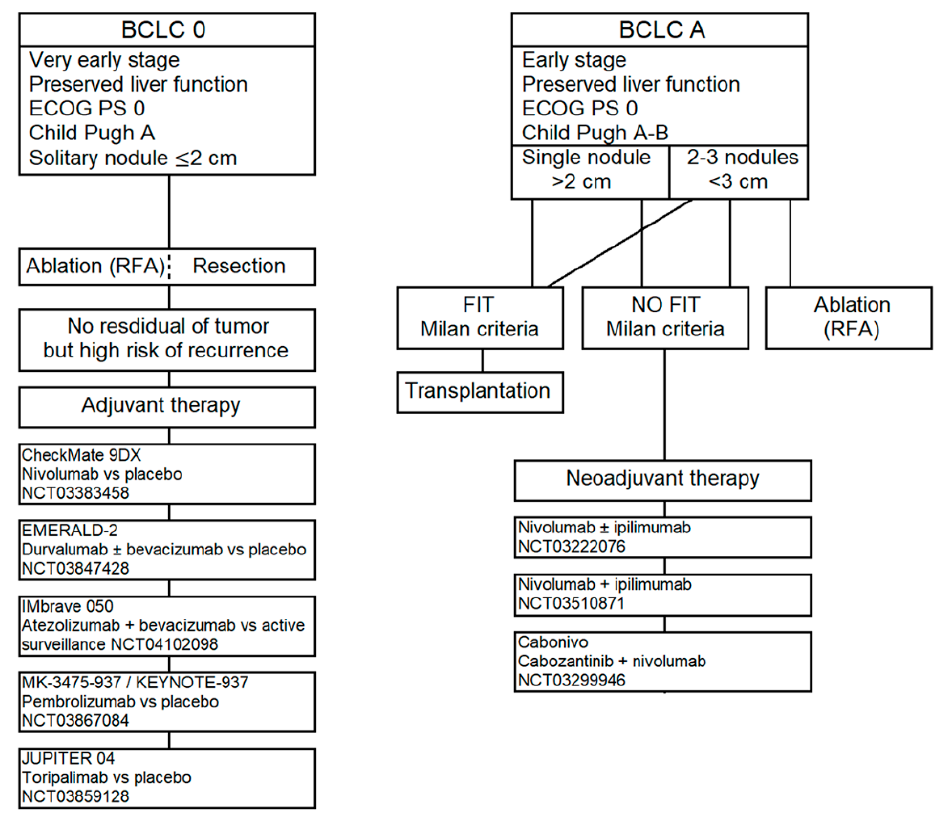
Figure 2. Treatment options and ICIs ongoing clinical trials for BCLC stage 0-A HCC.